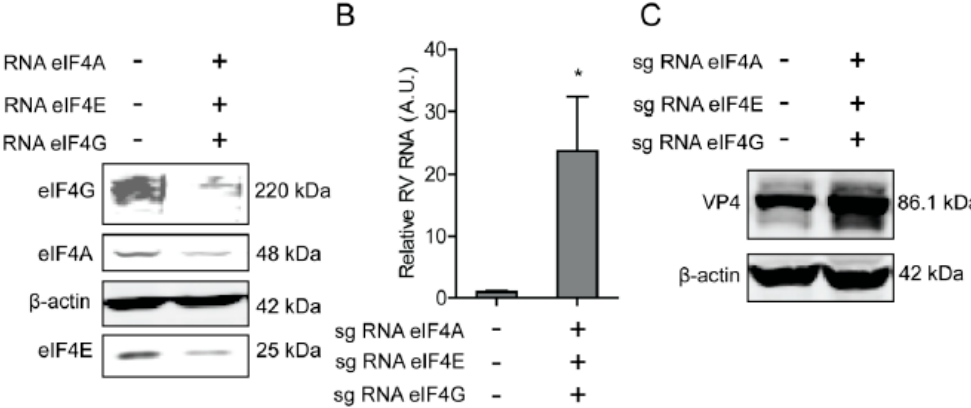
Figure 4. Silence of eIF4A/E/G promotes rotavirus infection. ( A ) Western blot assay detected eIF4 A/E/G in Caco2 cells transduced CRIPRs against eIF4A, eIF4E, and eIF4G. ( B ) Silence of eIF4A/E/G promoted the rotavirus genomic RNA level detected by qPCR assay ( n = 6, * P < 0.05, Mann–Whitney test). ( C ) Silence of eIF4A/E/G showed increased rotavirus protein VP4.